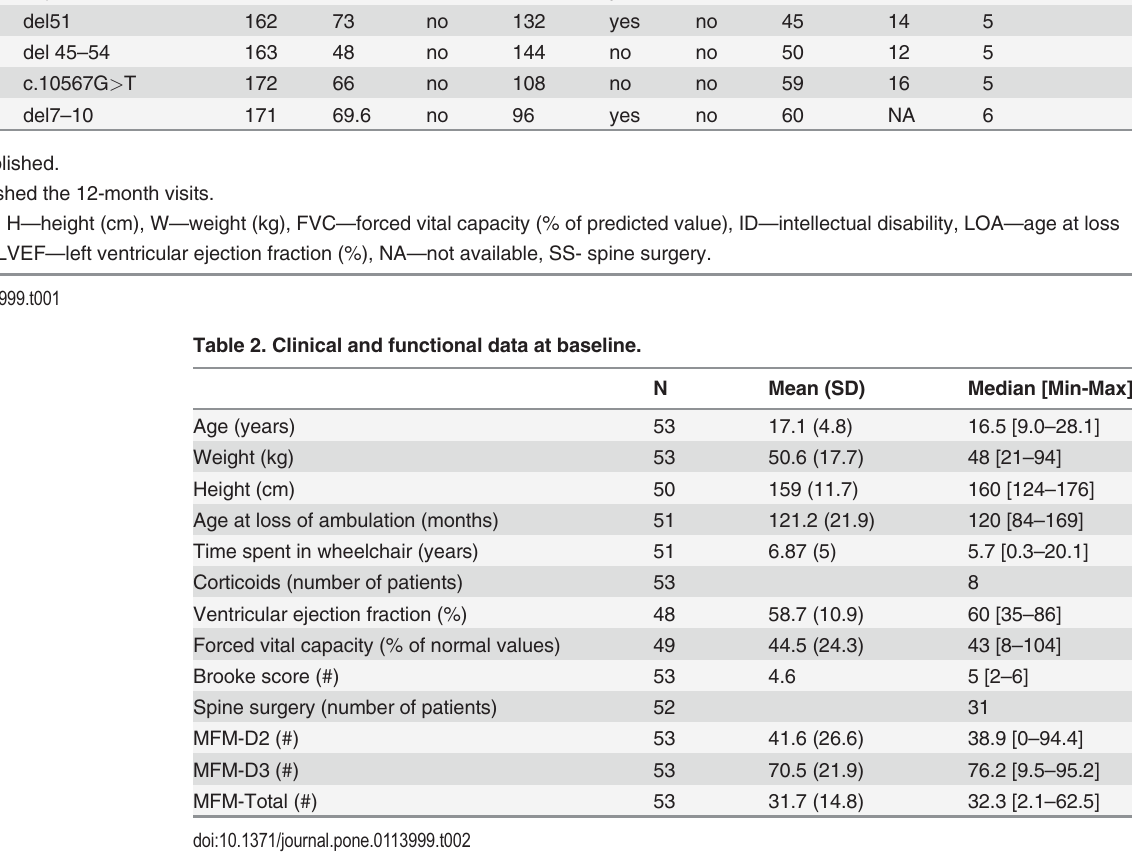
significant correlation between test scores and weight or height (data not shown). Data on cor- relations are summarized graphically in Fig. 2. One-year follow-up DMD patients showed a significant decrease in distal strength but not in function from base- line to 6 months and to one year for both dominant and non-dominant sides (Fig. 3, Table 5). Table 3. Correlations between strength and functional tests at baseline for the dominant (D) and the non-dominant (ND)